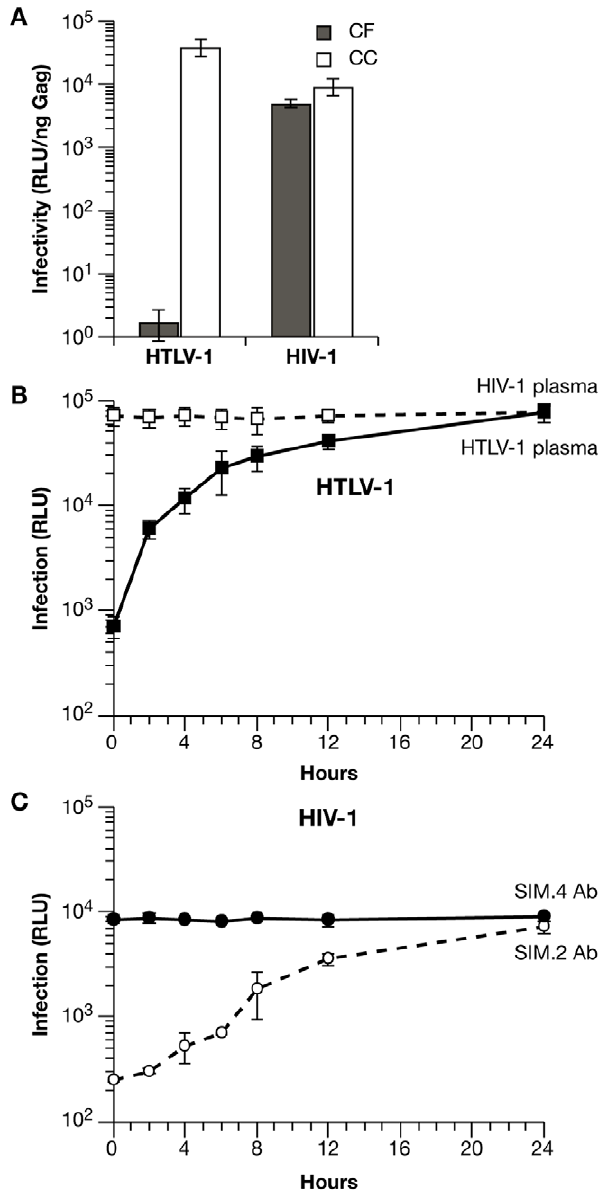
Figure 4. Differences in the mechanisms of transmission for HTLV-1 and HIV-1 in Jurkat-Raji/CD4 cocultures. ( A ) Compar- ison of cell-free (CF) and coculture (CC) infection. Raji/CD4 cells were infected with cell-free VLPs produced from transfected 293T cells or by coculture with transfected Jurkat cells. Luc activity is normalized relative to the amount of viral Gag protein in the supernatants. ( B ) The time course of HTLV-1 coculture infection was examined by blocking virus entry and infection with HTLV-1-infected human plasma (filled squares) at the indicated times after mixing transfected Jurkat cells and Raji/CD4 cells. Luc activity was measured 48 h after the start of coculture (0 h). For control infections, human plasma from HIV-1-infected patients was used (open squares). ( C ) Time course of HIV-1 coculture infection was examined by blocking virus entry and infection as in (B) except that anti-CD4 mAb SIM.2 (open circles) was used to block entry and non-blocking anti-CD4 mAb SIM.4 was used as control (filled circles). Luc activity was measured 48 h after the start of coculture (0 hr). These experiments were performed at least 3 times; error bars depict standard deviations.